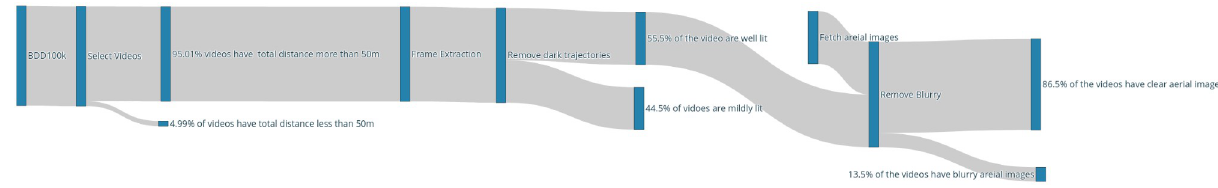
Fig 5. A simplified version of the data processing